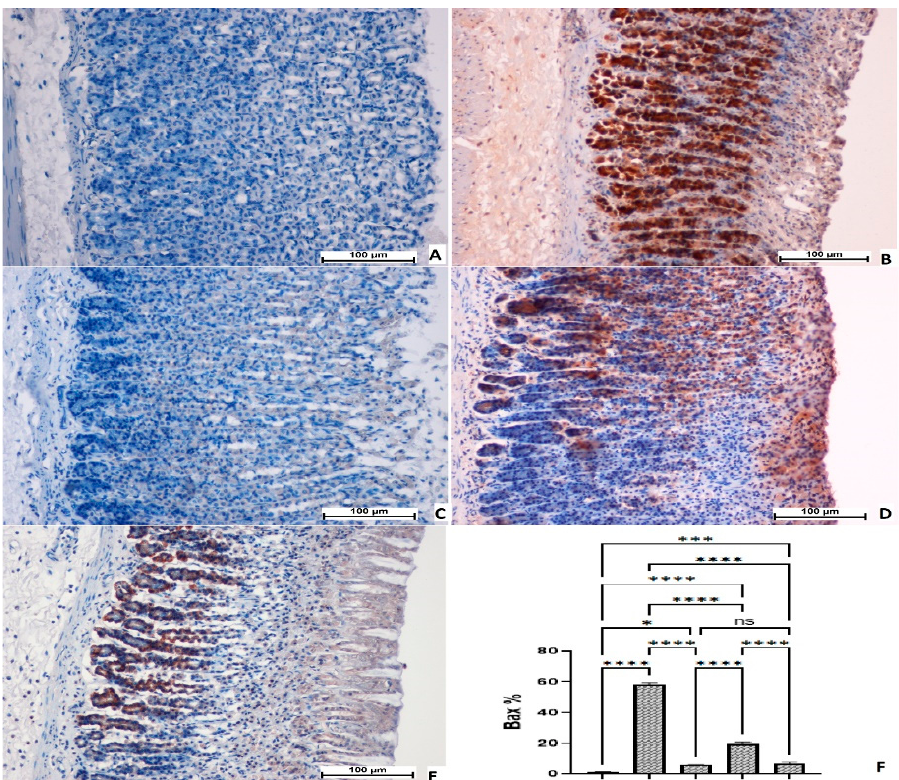
Figure 7. Influences of the PDE on the microscopic views of the stomach mucosa based on the Bax protein representation ( A – E ) and quantitative statistics ( F ) of the Bax protein expression by the stomach mucosa obtained from the ethanol-induced ulcerogenic rats. ( A ), normal control; ( B ), ulcer control; ( C ), reference rats (omeprazole, 20 mg/kg); ( D ), rats received 200 mg/kg of the PDE; ( E ), rats received 400 mg/kg of the PDE. Normal control rats had a normal appearance of their stomach tissues and significantly the lowest representation of the Bax protein in their gastric tissues ( A , F ). Ulcer control rats experienced severe stomach tissue damages with increased representations of the Bax protein in their gastric mucosa ( B , F ). Reference rats had a mild stomach tissue injury with significantly decreased representations of the Bax protein in their mucosal linings, compared to the ulcerogenic rats ( C , F ). Rats administered 200 mg/kg of the PDE had a moderate gastric tissue injury with significantly reduced representations of the Bax protein, compared to the ulcerogenic rats ( D , F ). Rats administered 400 mg/kg of the PDE showed a gastric mucosal injury and significantly lower representations of the Bax protein than those of the ulcerogenic and low dose treated rats ( E , F ). Non-significant changes observed in the quantitative measurements of the Bax protein expression between the C and E rat groups. (Bax stain, magnification 20 × ). Values expressed as means ± SEM. Antigen areas observed in a brown color. The significant levels in the Bax protein expressions are presented as ns, non-significant; *, p < 0.05; ***, p < 0.001; ****, p <